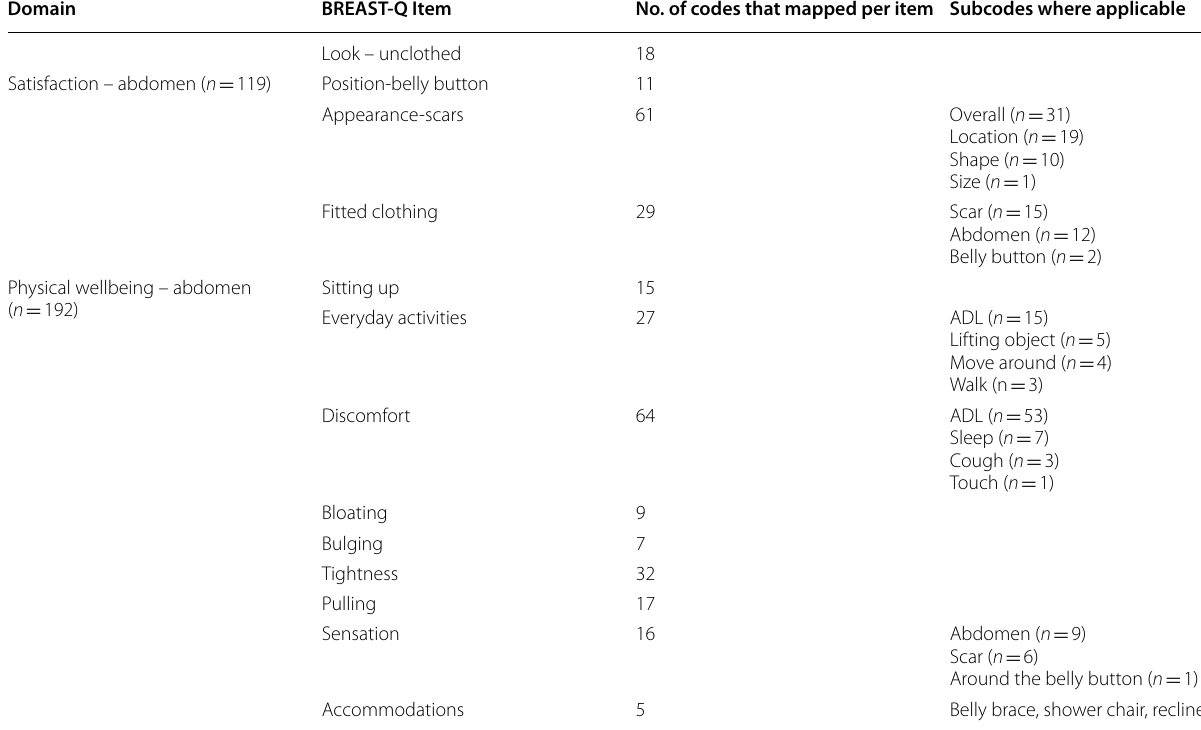
Codes highlighted in italic did not map to the BREAST-Q;ADL, activities of daily living